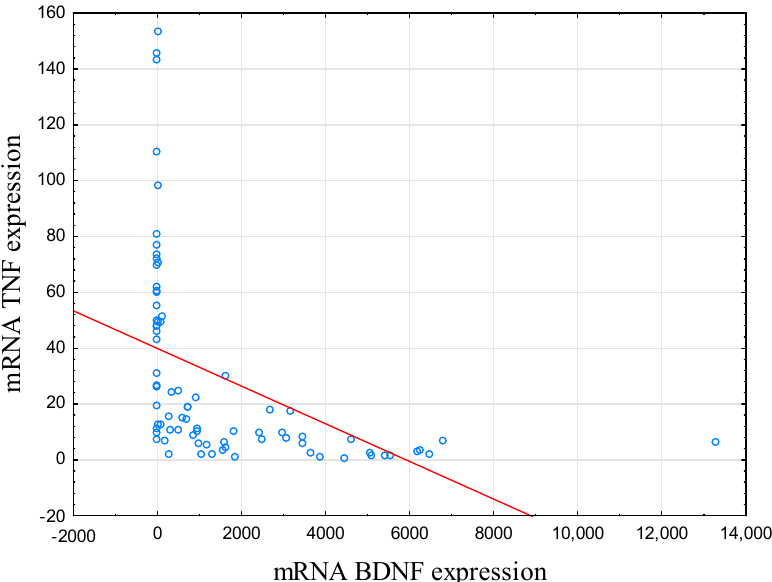
Figure 1. Correlation between mRNA BDNF and mRNA TNF expression. In IBD subjects, there was a negative correlation between BDNF and TNF mRNA expression level (r = − 0.758, p < 0.001). Abbreviations: BDNF—Brain-Derived Neurotrophic Factor, TNF—Tumor Necrosis Factor. It was observed that BDNF mRNA expression in HCs was higher than that in the IBD